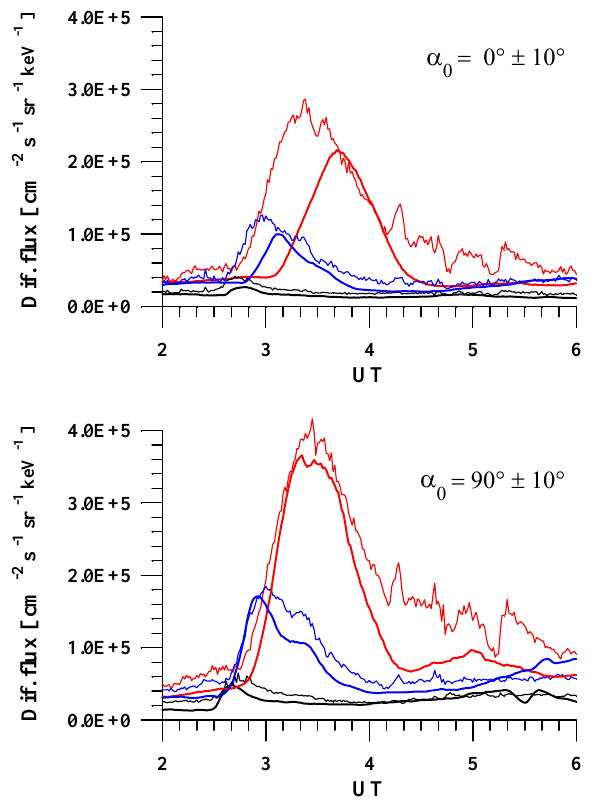
Fig. 3. Differential fluxes along (upper plot) and across (bottom plot) the geomagnetic field at 30–45, 45–65, and 65–95keV (the red, blue, and black line, respectively). The fluxes obtained by the LANL-129 satellite are shown by the thin line. Results of tracing the fluxes, observed by LANL-097, to the longitude of LANL-129 are shown by the bold